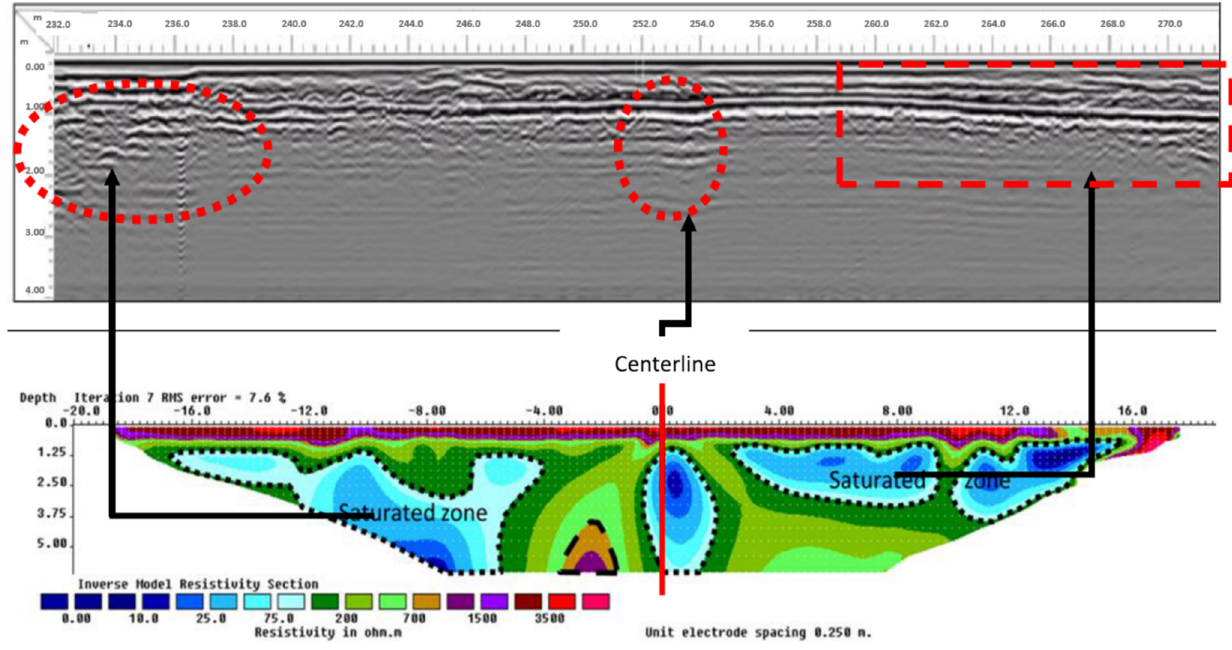
Figure 11. GPR profile ( top ) showing saturated/contaminated area surrounded by red dots, and the corresponding ERT profile ( bottom ) surrounded by black dots [165]. corresponding ERT profile ( bottom ) surrounded by black dots